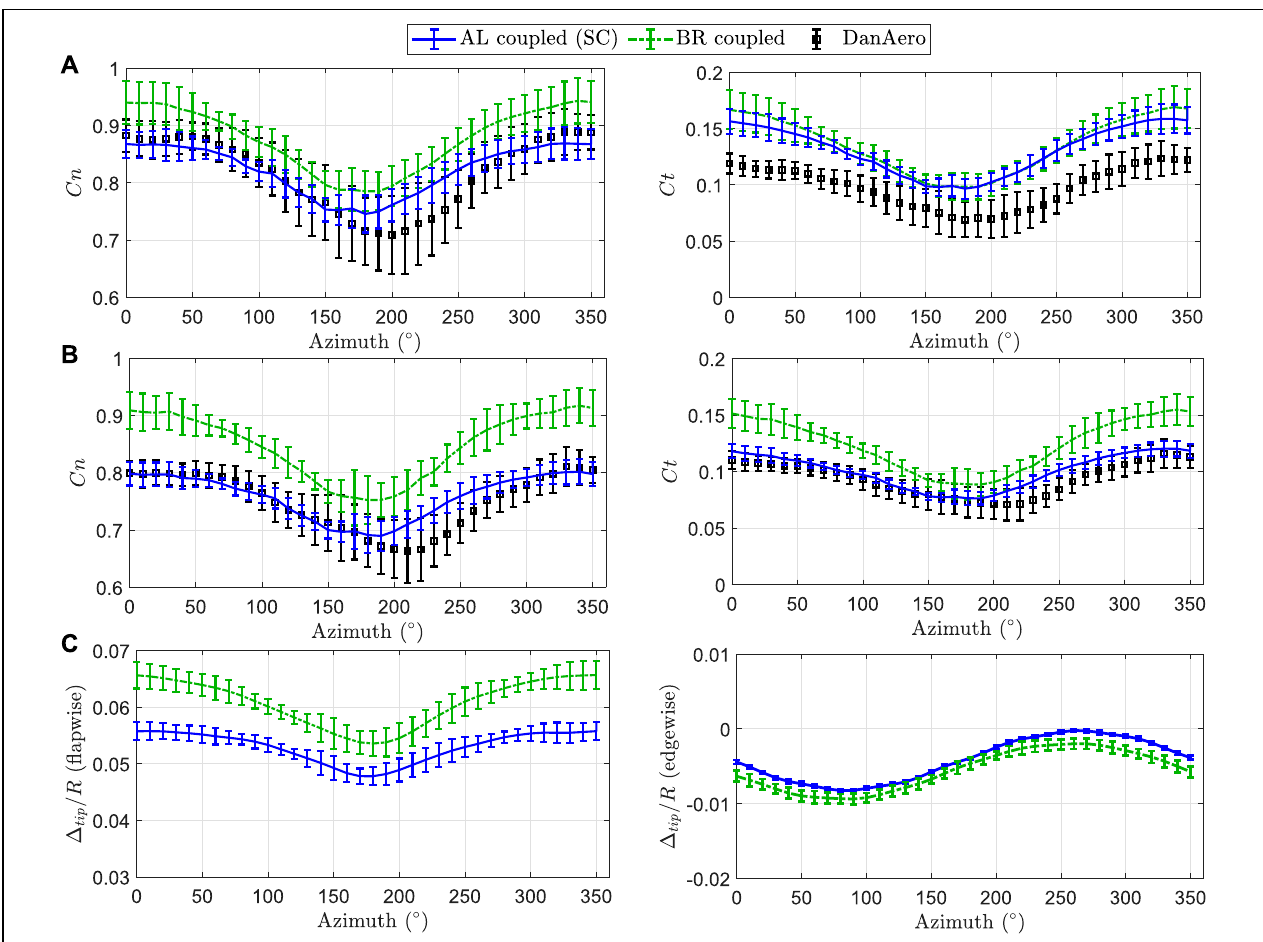
FIGURE 8 | Case 4: high shear, low yaw and turbulence. (A) Normalised normal and tangential blade loads at 75% radius; (B) Normalised normal and tangential blade loads at 90% radius; (C) Normalised flapwise and edgewise tip